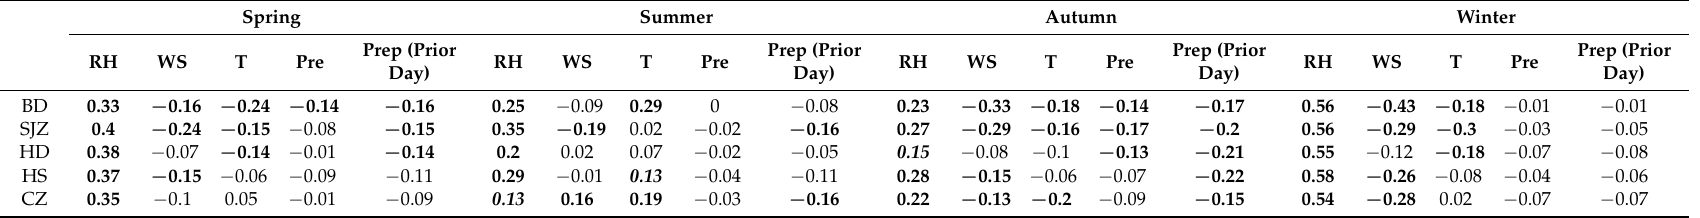
Table 2. Pearson correlation coefficients between daily PM 2.5 concentrations and meteorological factors in five cities during